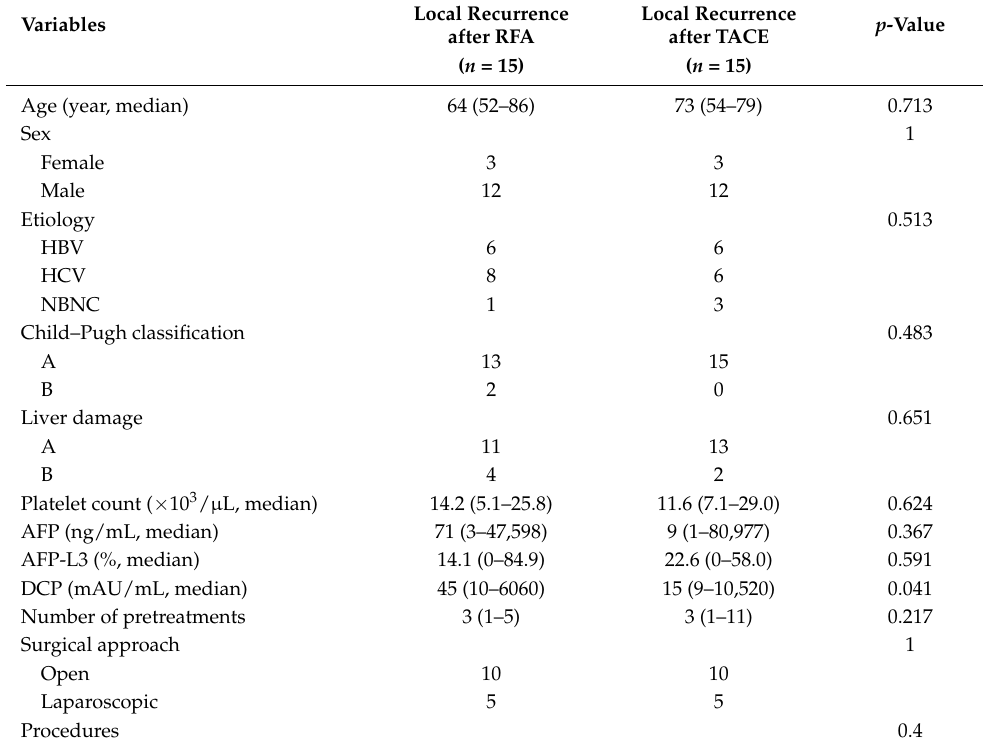
Table 3. Patient characteristics stratified by the previous locoregional therapies for LR-HCC.